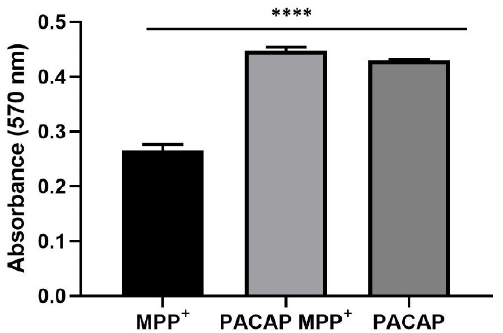
Figure 14. Prestoblue assay on 3D SH-SY5Y/RA/MPP + (MPP + ) and 3D SH-SY5Y/RA/MPP + treated with gH625-lipoPACAP-Rho (PACAP MPP + ) and 3D SH-SY5Y/RA treated only with gH625-lipoPACAP-Rho (PACAP). The 3D SH-SY5Y/RA spheroids show higher viability when treated with gH625-lipoPACAP-Rho (PACAP MPP + and PACAP), compared to 3D SH-SY5Y/RA/MPP + (MPP + ).